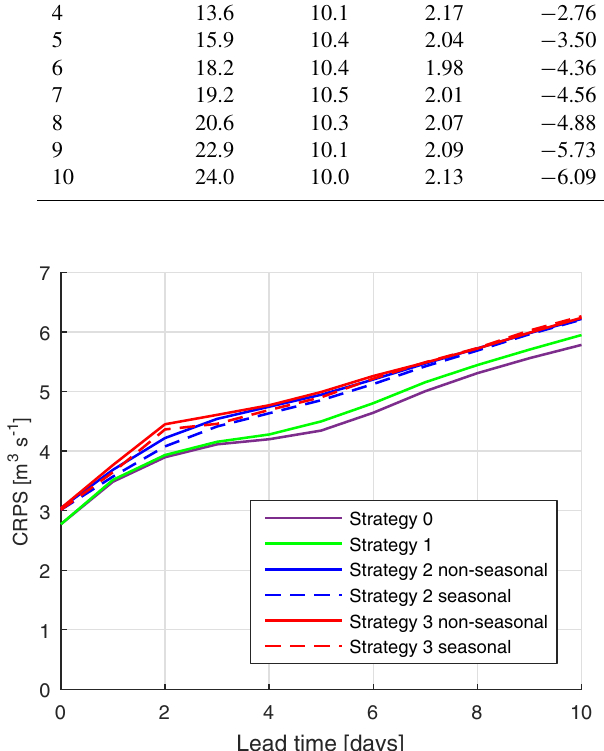
Figure 5. CRPS of streamflow forecasts over the validation period 2008–2011, by applying the pre- and post-processing strategies that are introduced in Sect.